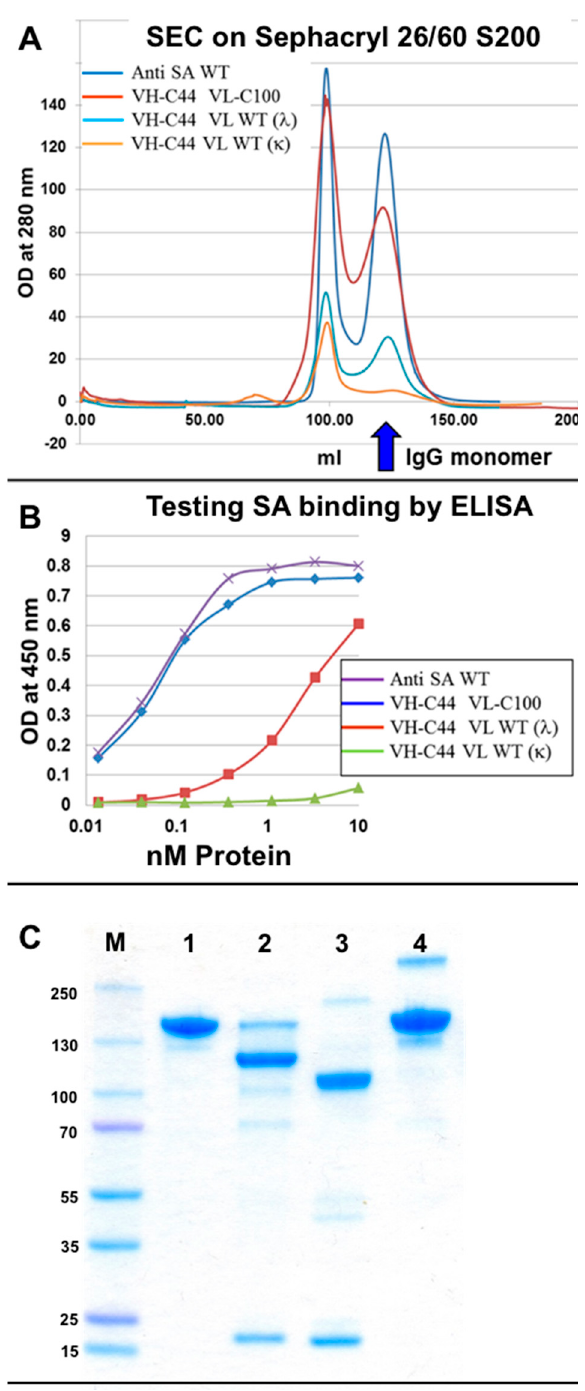
Figure 6. Evaluation of “wrong” H–L pair formation. Four antibodies were evaluated: a WT α SA, a V H C44 heavy chain of α SA refolded with V L C100 λ light chain of α SA, a V H C44 heavy chain of α SA refolded with a WT λ light chain of α SA, a V H C44 heavy chain of α SA refolded with WT κ light chain of T427 The four antibodies were refolded at the same scale, purified over a MabSelect column and the column eluate was loaded on a Sephacryl 26/60 S200 size exclusion chromatography (SEC) column ( A ). ( B ) Evaluation of SA binding by the monomeric fractions from ( A ) by ELISA. ( C ) antibodies expressed in Expi293™ mammalian cells: (1) The commercial therapeutic mAb Infliximab shown as a reference to full-size IgG; (2) α SA Heavy chain hole T427 Heavy chain knob C44 C222A, with T427 Light chain WT; (3) α SA Heavy chain WT T427 Light chain C100 C214 Δ ; (4) α SA Heavy chain WT, T427 Light chain WT.